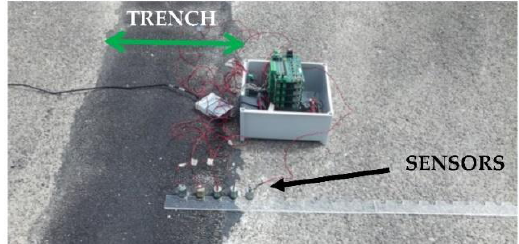
Figure 12. Example of positioning of the experimental device for signal acquisition (reception chain).